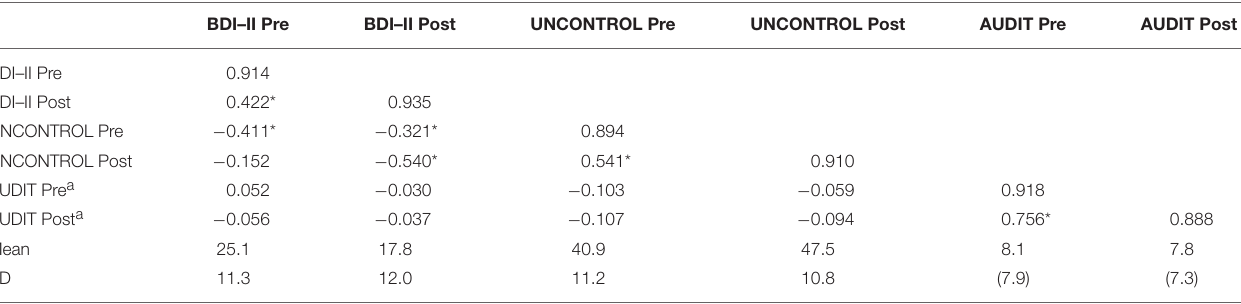
TABLE 3 | Zero-order correlations between BDI–II, AUDIT, and UNCONTROL measured before the course started to ∼ 6 months later ( N =